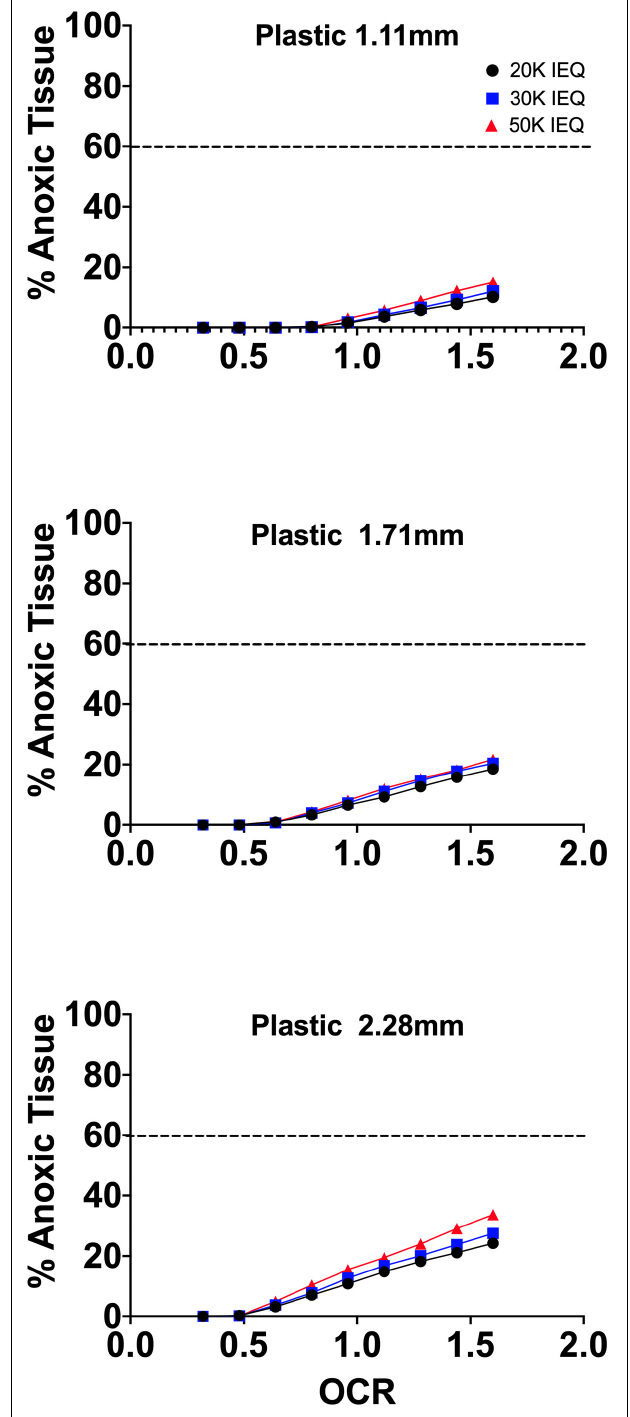
FIGURE 6 | FEM of low temperature islet culture on conventional plastic culture systems. The reduction of temperature significantly reduces tissue anoxia due to the relative Arrhenius drop in oxygen consumption rate (68%) indicated along the x -axis (0.32 × standard islet OCR values, temperature culture relative to standard culture settings and dependent on seeding density and culture medium